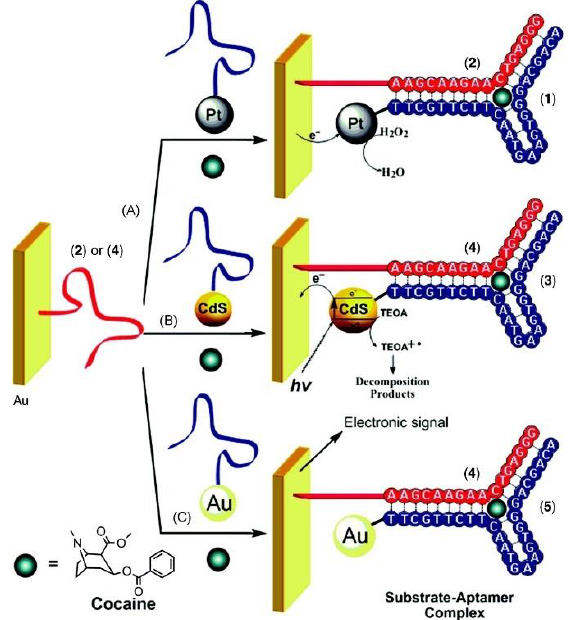
Figure 6. Electrochemical (Path A), photoelectrochemical (Path B), and surface plasmon resonance (SPR) (Path C) analysis of cocaine. Reproduced with the permission of [125]. Copyright 2009 Published by American Chemical Society.